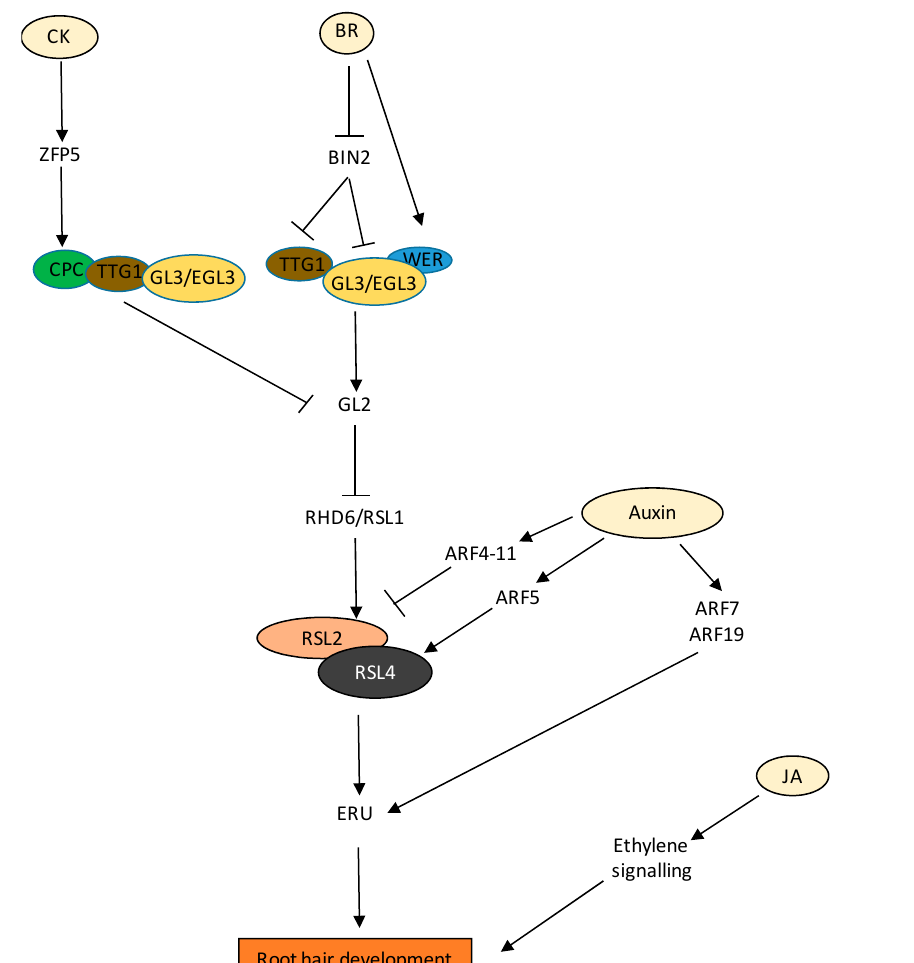
Figure 5. Regulation of RH development by various hormones and their crosstalk.BR positively regulates the expression of WER, GL2 (negative regulator of RH development) and inhibits BIN2, which is then unable to phosphorylate GL3/EGL3 and TTG1. Presence of BR promotes functional TF complex formation between TTG1, GL3/EGL3, and WER, promoting GL2 expression, leading to inhibition of the RH development pathway. CK induces TF ZFP5, which promotes the expression of CPC (positive regulator of RH development), leading to the formation of functional TF complex of TTG1, GL3/EGL3, and CPC. The complex inhibits the ex- pression of GL2, thus causing activation of the RH development pathway. The presence of auxin liberates the ARFs from AUX/IAAs. The ARFs show different specificity to RH development. ARF4-11 inhibits, whereas ARF6 promotes, the RH develop- ment pathway. ARF5 directly interacts with the promotor of RSL4 , leading to RH development. Auxin also directly regulates the expression of RSL4 target gene ERU via ARF7/ARF19. JA positively influences RH growth via ET signalling. Solid black arrows indicate confirmed pathways.